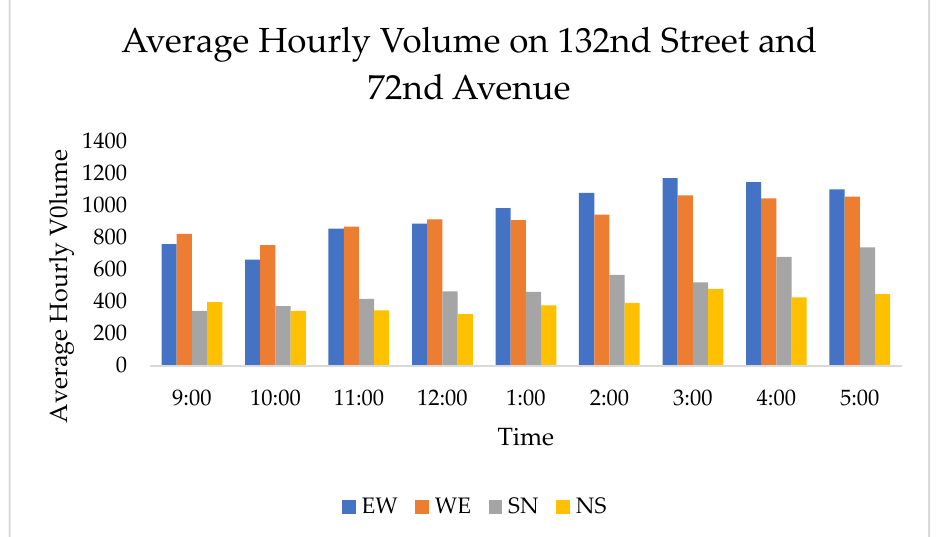
Figure 6. Hourly average traffic volumes on 132nd Street and 72nd Avenue.